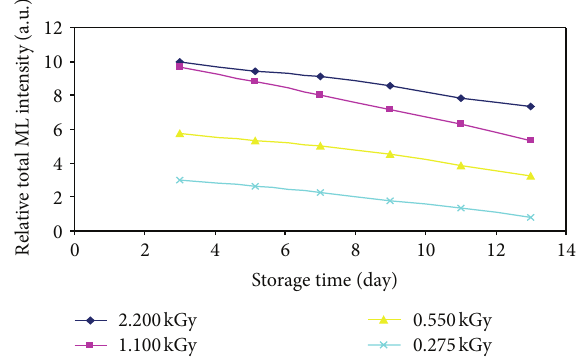
Figure 3: Fading of total ML intensity of MgAl 2 O 4 : Dy (0.1mol%) phosphor (massof thesample 1mg, massof the piston0.7 kg, impact velocity 2.33 ms −1